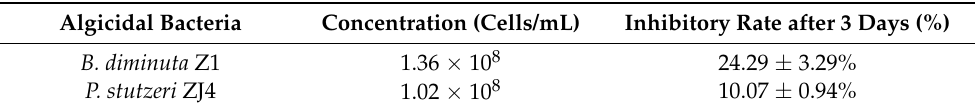
Table 1. Algicidal effects of B. diminuta Z1 and P. stutzeri ZJ4 washed cells against unicellular M. aeruginosa . Algicidal Bacteria Concentration